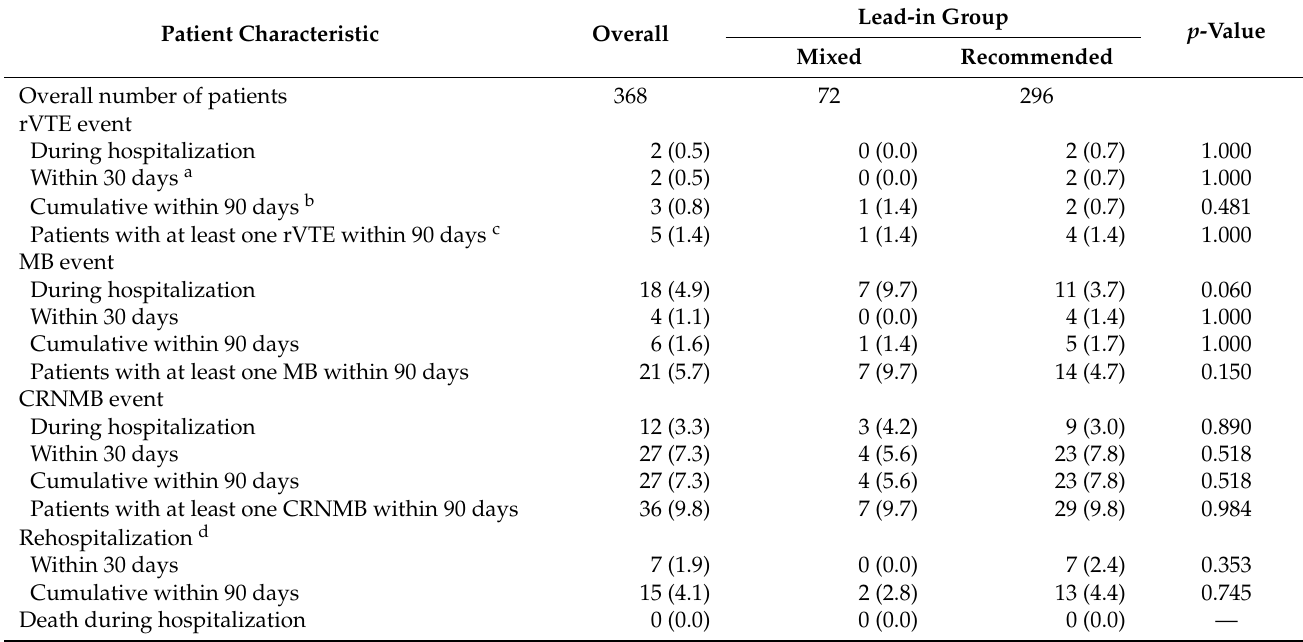
Table 5. Outcomes during hospitalization and up to 90 days after the VTE